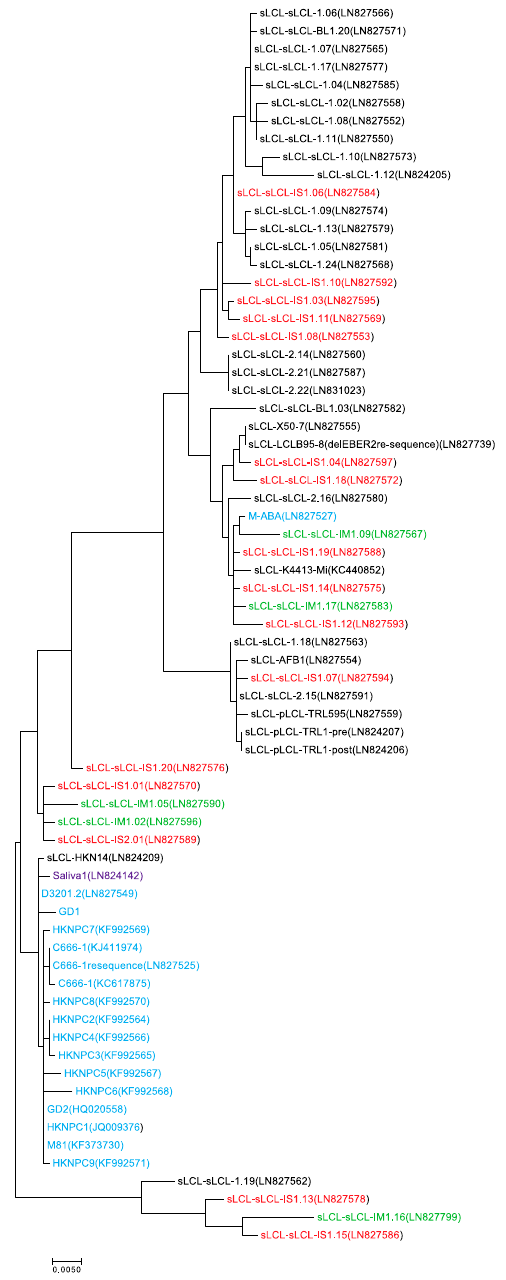
Figure 2. Maximum-likelihood phylogeny of LMP1 sequences. LMP1 sequences were derived from NPC patients (blue) or spontaneously immortalized lymphoblastoid cell lines (sLCLs) (black), which were further grouped by infectious mononucleosis (green) and post-transplant lymphoproliferative disease (red). One sample was directly sequenced from the saliva of a healthy donor (purple). The evolutionary history was inferred by using the Maximum Likelihood method based on the Tamura-Nei model in MEGA7 [100,101]. The tree is to scale, with branch lengths measured in the number of substitutions per site. The analysis involved 69 informative nucleotide sequences. All positions containing gaps and missing data were eliminated, leaving a total of 991 positions in the final dataset.